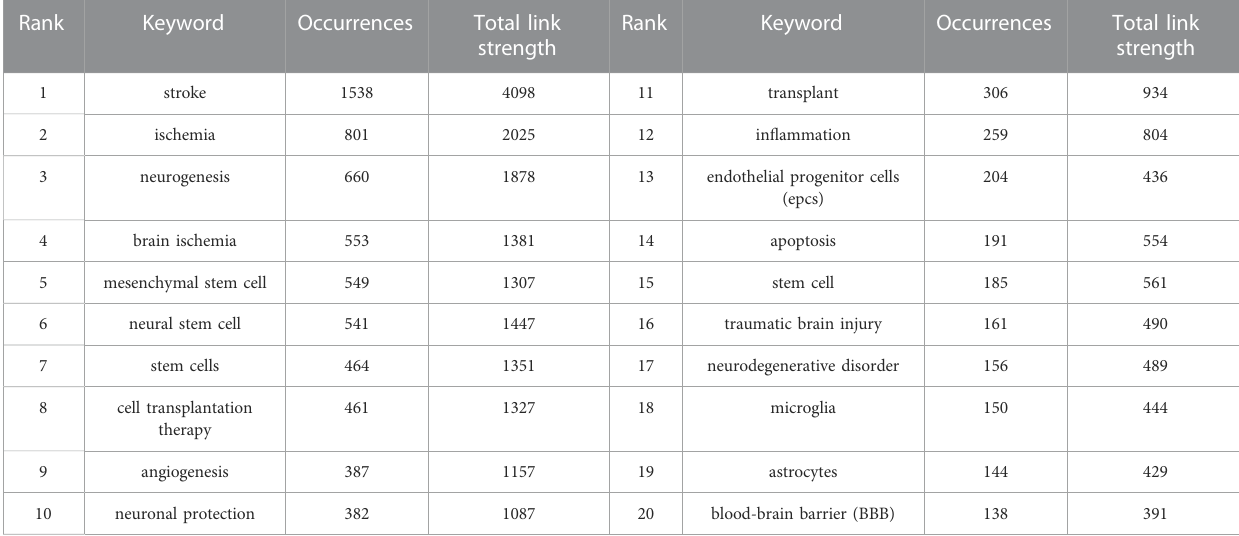
TABLE 6 Top 20 keywords related to stem cells in